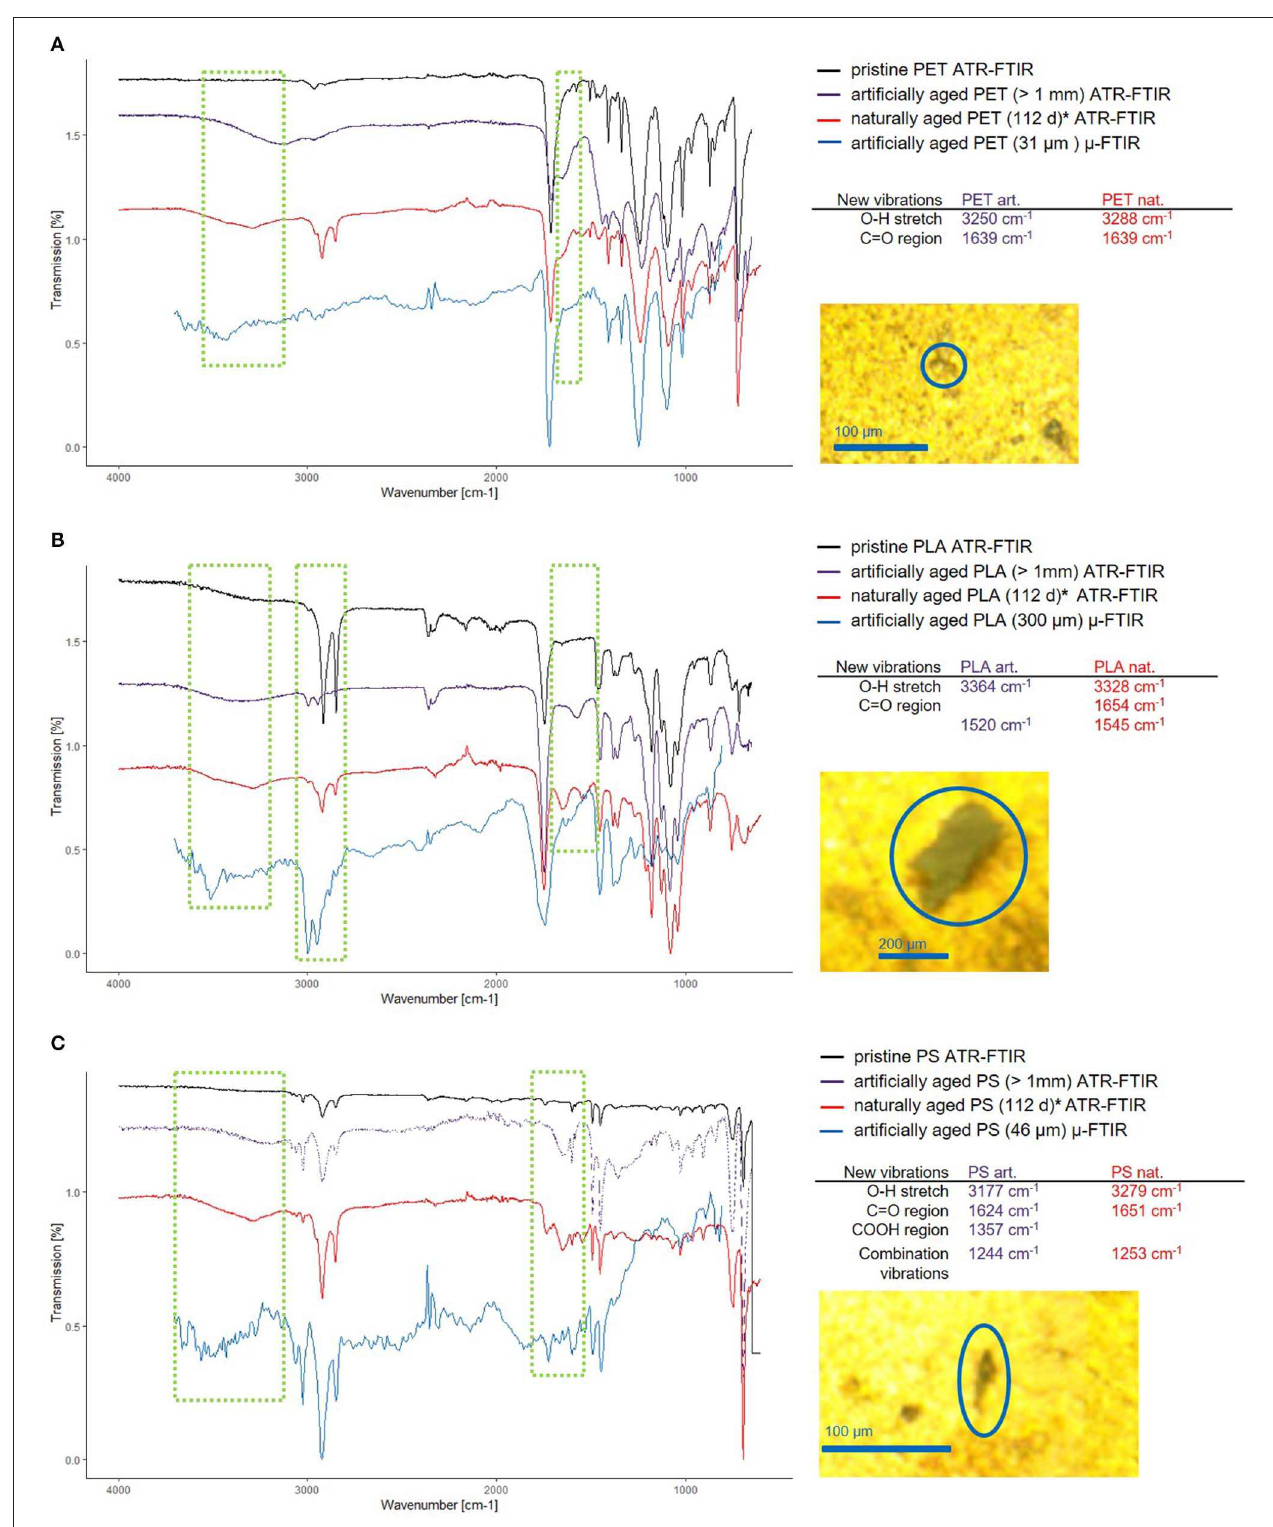
FIGURE 8 | Comparison of the new vibrations in artificially and naturally aged polymers. Thanks to Scott Lambert and Martin Wagner, who provided the data for 112 days aged MP (Lambert and Wagner, 2016) (marked with *), a comparison between naturally and artificially aged MP was possible. The ATR-FTIR spectra for pristine (black) artificially aged (purple) and naturally aged (red) and reflectance µ -FTIR spectra of small artificially aged MP (blue) are shown for PET (A) , PLA (B) , and PS (C) , wherein the regions of interest are marked (green squares). The positions of the bands corresponding to the newly formed functional groups of the ATR-FTIR measurements are listed and the microscopy images of the particles analyzed are displayed to the right side of the spectra.